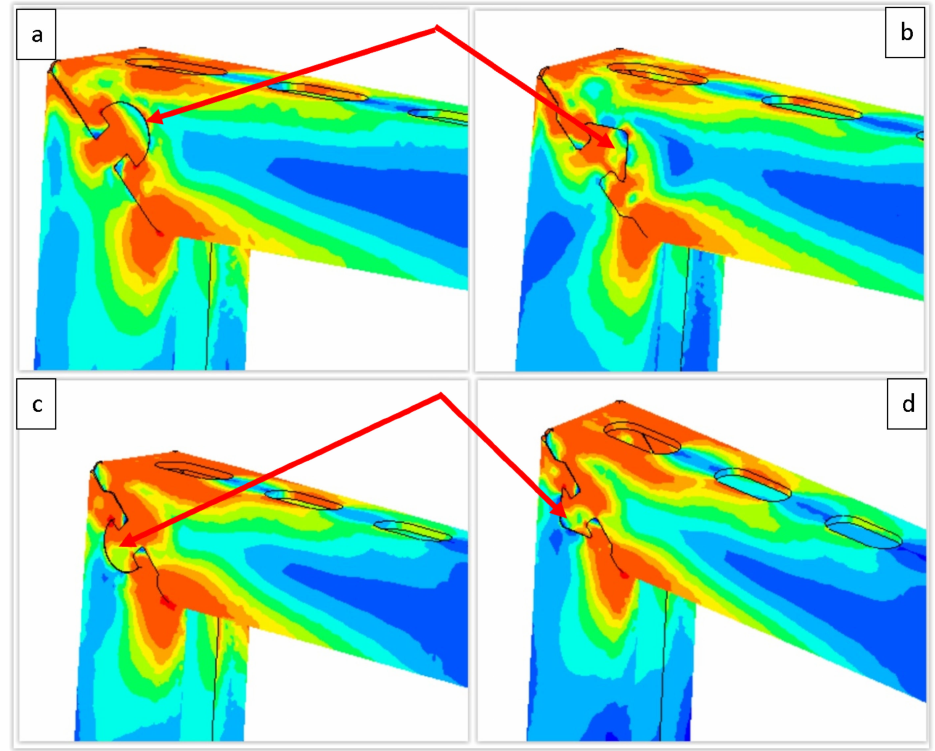
Figure 16. Exemplary FEM results showing distributions of equivalent stresses around the lock: semicircular ( a ) and an arrow ( b ) pointing down ( c ) and up ( d ), respectively. Standard profile of 40 mm × 40 mm cross-section